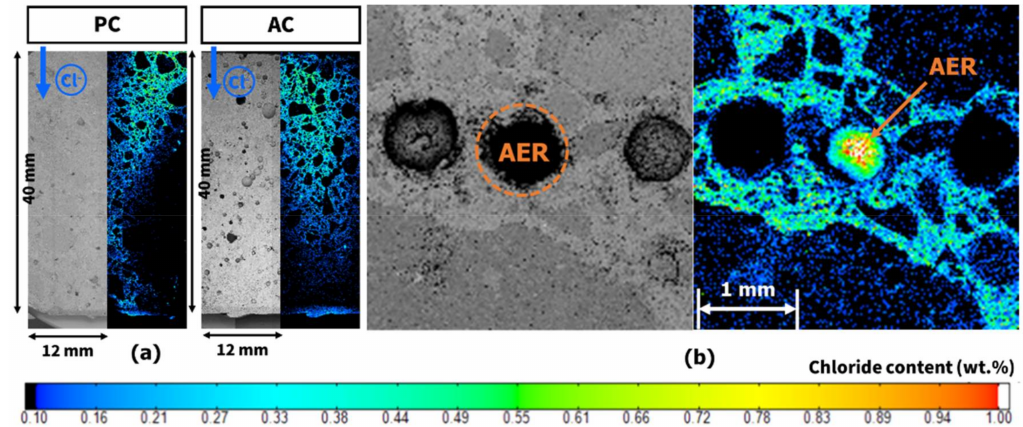
Figure 9. EPMA image: ( a ) chloride profile of the mortar sections; and ( b ) chloride content around the